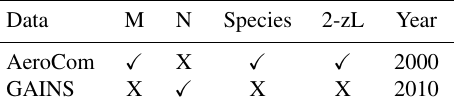
Table 1. Input data provided from AeroCom and GAINS invento- ries for submicron particle emissions. The data are sorted accord- ing to their original structure in terms of mass, number, chemical species differentiation (BC, OC and SO 4 ), bi-level vertical distribu- tion (2-zL) and base year. (cid:88) and X indicate, respectively, whether the inventory contains certain information or